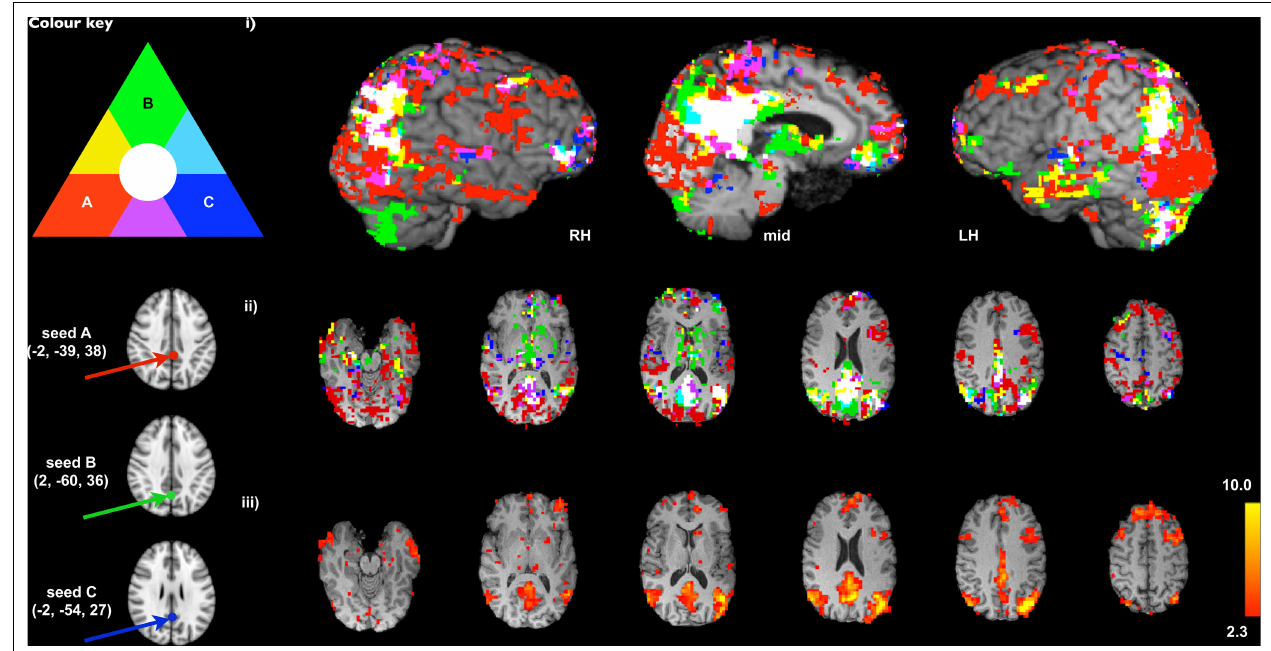
FIGURE 2 | Comparison of SCA-derived versions of the DMN using three different seed voxel locations proposed in the literature ( A : Fox et al., 2005 in red; B : Singh and Fawcett, 2008 in green; C : Greicius et al., 2003, in dark blue). The results of SCA analysis using these seeds are displayed (i) as maximum intensity projections (searching up to 12 voxels below the surface or slice on 3-D renderings of a single subject’s high-resolution MRI; RH = right hemisphere, mid = midline, LH = left hemisphere), and (ii) as binarised thresholded Z-statistic